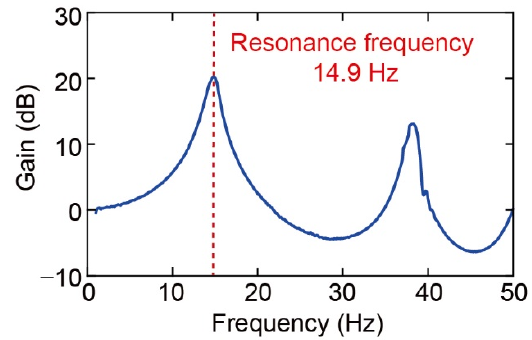
Figure 11. Frequency response of the force plate.